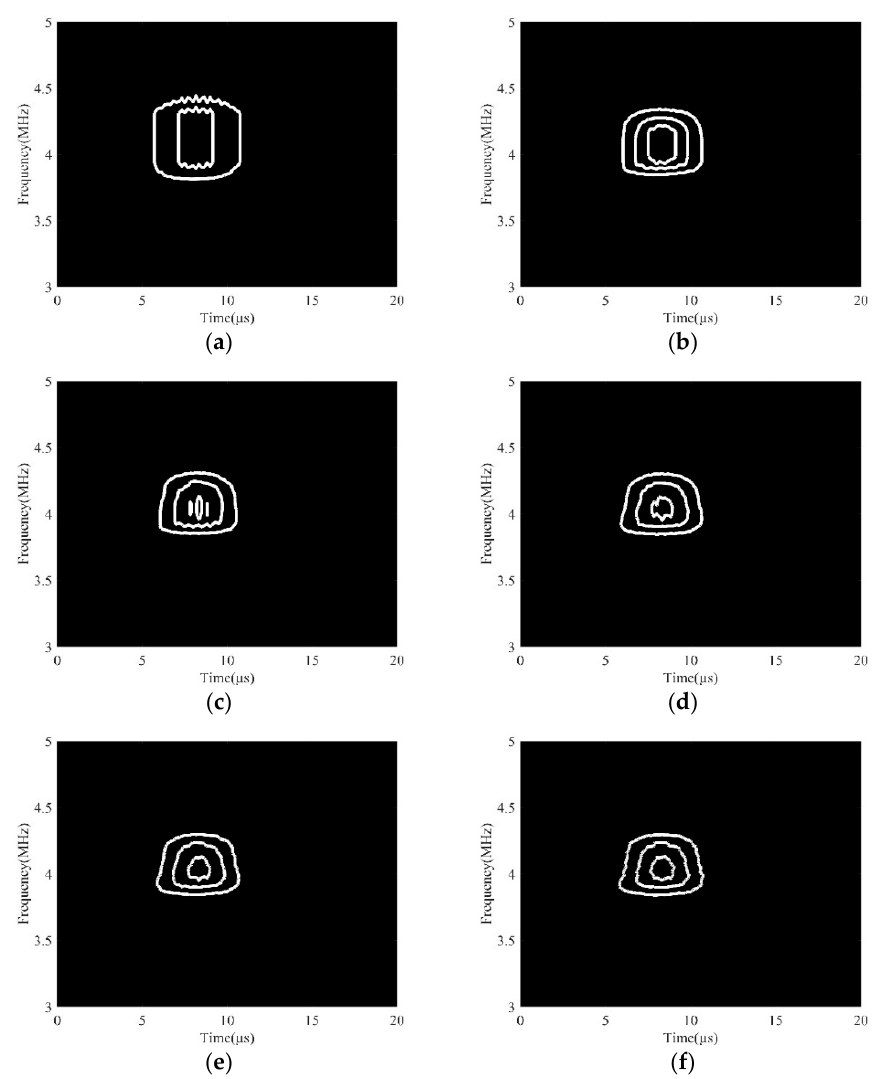
Figure 5. The DWFP images within different scales. ( a ) 64; ( b ) 128; ( c ) 256; ( d ) 512; ( e ) 1024; ( f ) 2048.